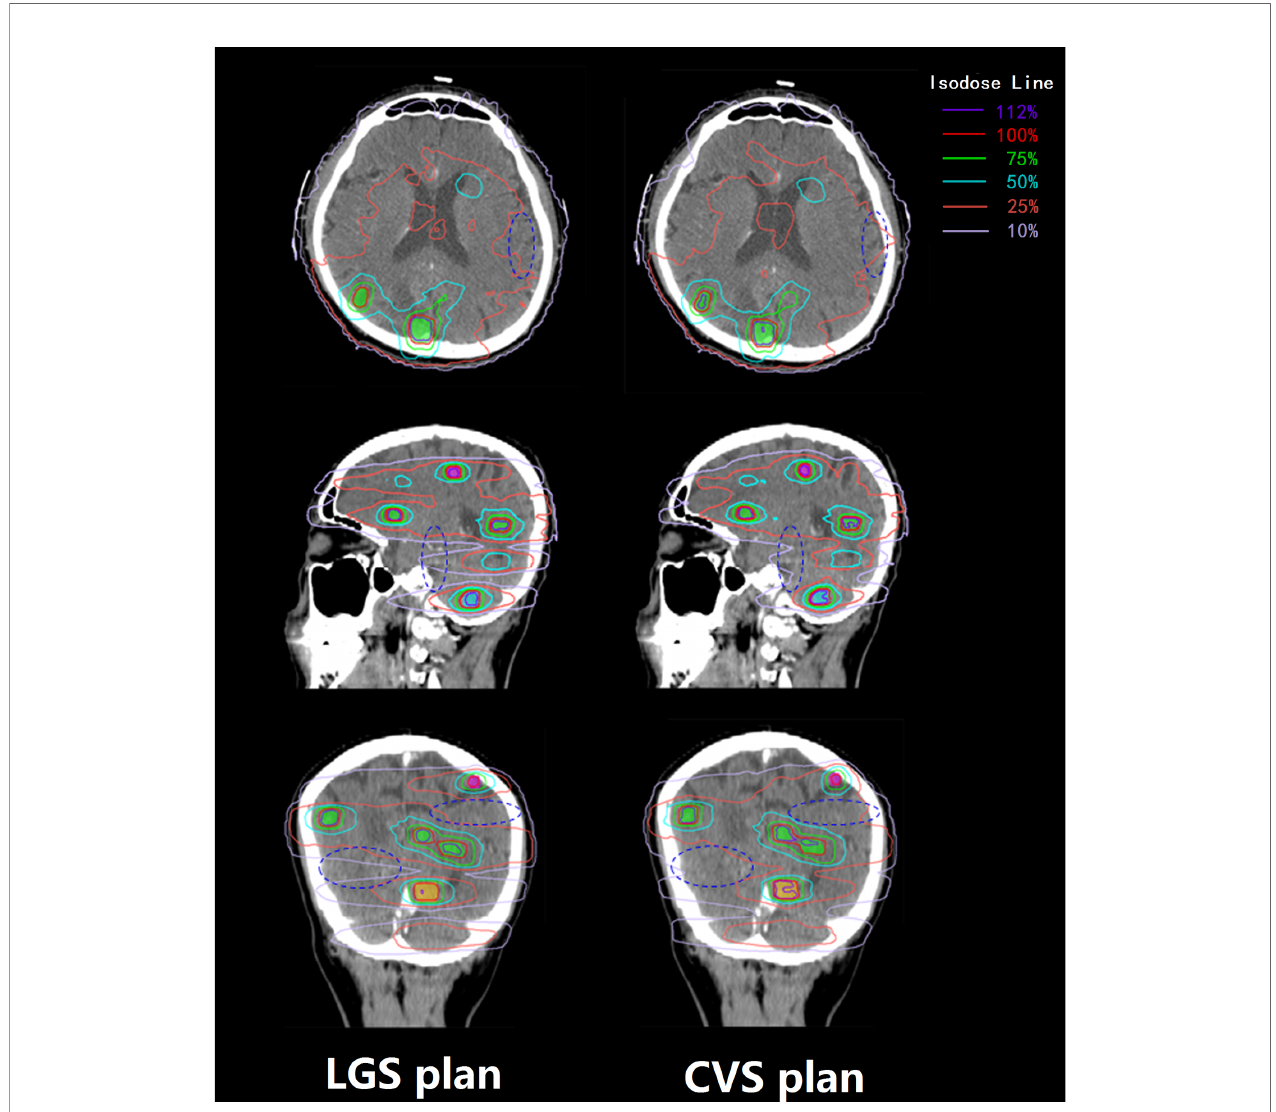
FIGURE 3 | Transverse, sagittal, and coronal dose distributions of two plans for an example patient. The patient had 14 BMs, which were divided into four groups. The 100, 75, and 50% prescription isodose lines did not show much difference between the two plans, but the differences between the 25 and 10% prescription isodose lines between the two plans were obvious. The dark blue ovals mark the areas where there is a signi fi cant difference in dose distribution between the two